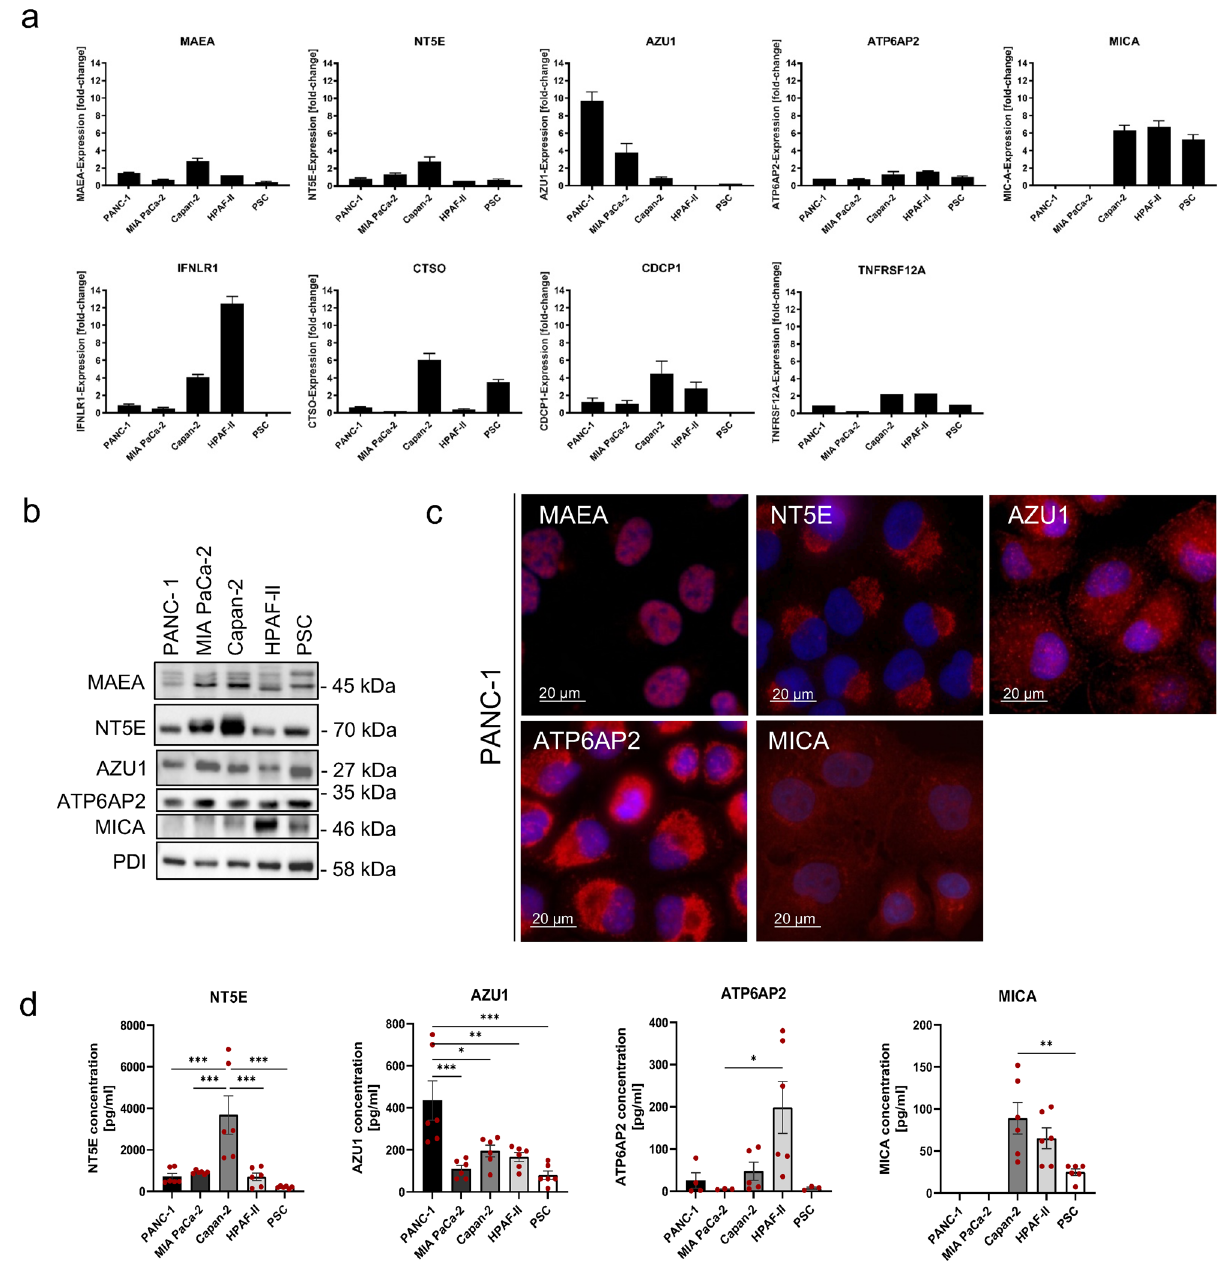
Figure 2. Characterization of proteins in pancreatic cancer cell lines (PANC-1, MIA PaCa-2, Capan-2, HPAF-II) and pancreatic stellate cell line (PSC). ( A ) The mRNA levels were determined by qPCR for the genes MAEA, NT5E, AZU1, ATP6AP2, MICA, IFNLR1, CTSO, CDCP1 and TNFRSF12A. The expression level of each gene was normalized against β-actin. Data is presented as mean ± SEM (n = 3). ( B ) Expression of MAEA, NT5E, AZU1, ATP6AP2 and MICA was detected by Western blot analysis. Representative Western blots were selected from three independent experiments. PDI was included as a loading control. Full membrane blots are provided in Supplementary Figure S1. ( C ) Representative immunofluorescence images of PANC-1 cells stained for MAEA, NT5E, AZU1, ATP6AP2 and MICA (red). Nuclei are stained in blue with DAPI. ( D ) Protein concentrations of NT5E, AZU1, ATP6AP2 and MICA in cell culture supernatants were determined by sandwich ELISAs. For values outside the linear range, the value of the smallest standard as minimum or the value of the largest standard as maximum was used for presentation. The mean value ± SEM is given (n = 3 in duplicates). Statistical evaluation was performed by one-way ANOVA + Tukey’s post-hoc test): *p < 0.05; **p < 0.01; ***p <